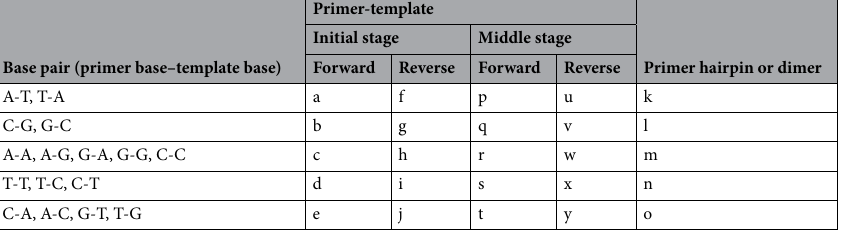
Base pair (primer base–template